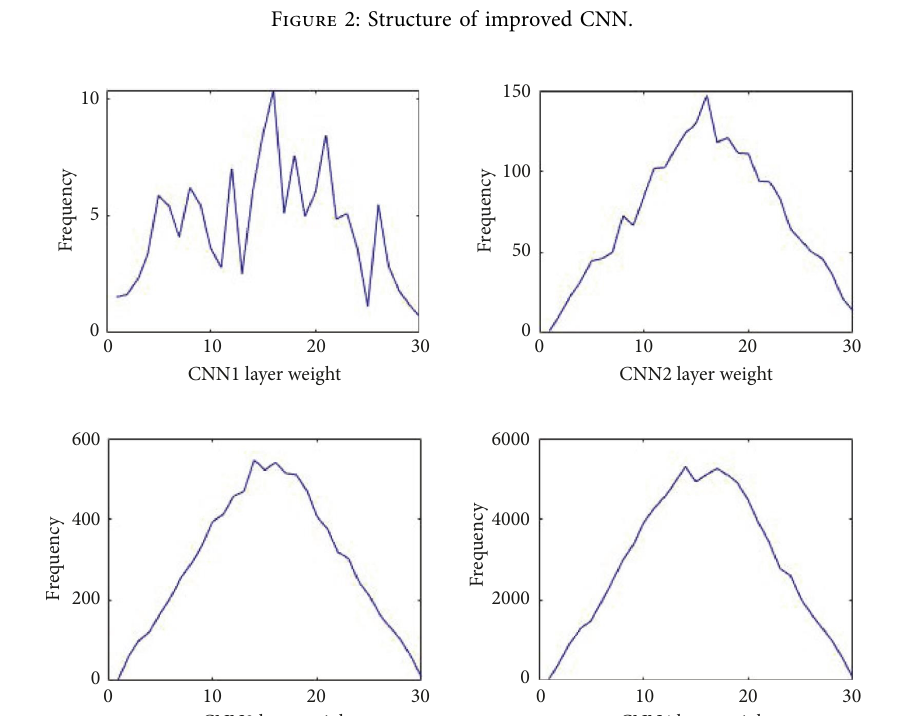
Figure 3: Layers of the weight of the frequency distribution after 500